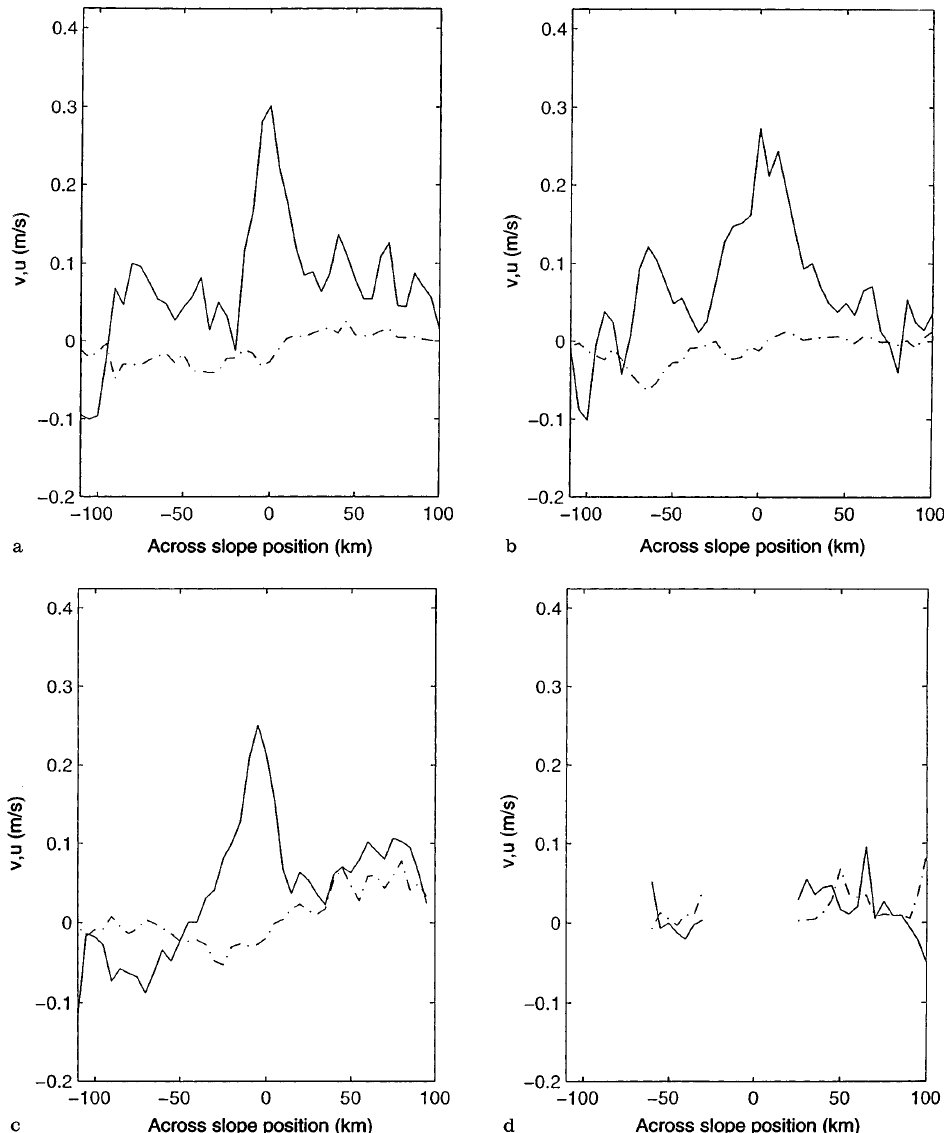
Fig. 5a–d. Average along-slope, Y , ( solid line ) and across-slope, X , ( dot-dashed ) velocity profiles during a, b winter and c, d summer adjacent to the a, c Hebrides and b, d Shetland Shelf breaks for days